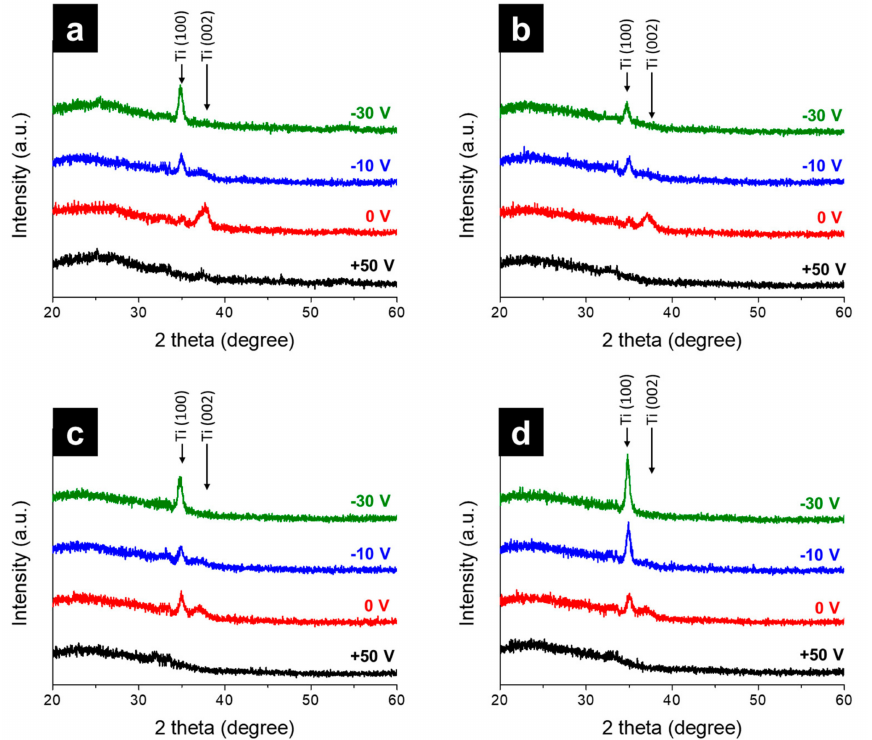
Figure 6. XRD data of the Ti films deposited at the substrate bias of − 30, − 10, 0, and +50 V under ( a ) 20 mTorr, ( b ) 40 mTorr, ( c ) 60 mTorr, and ( d ) 80